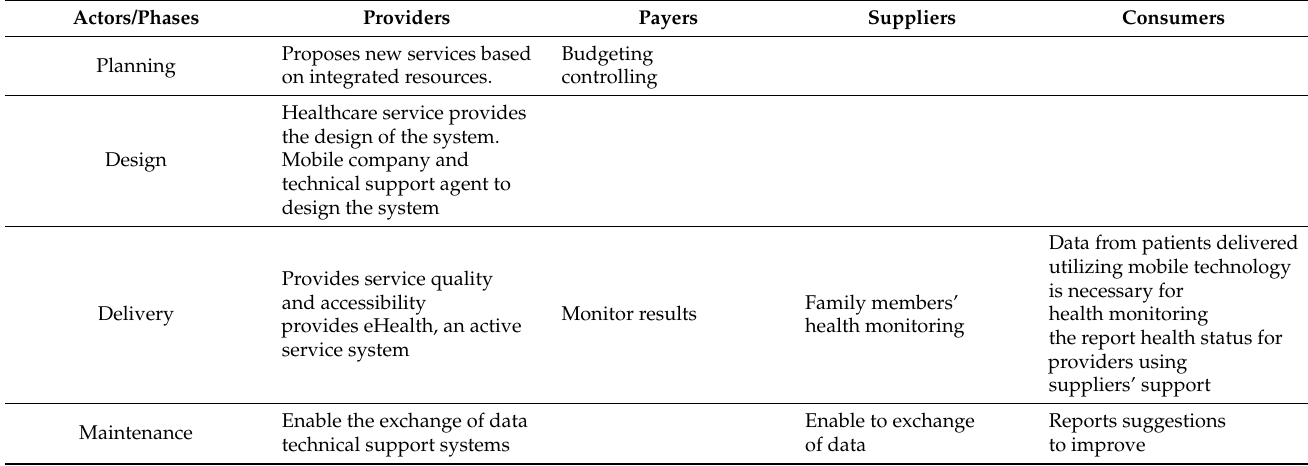
Table 4. Cocreation matrix for